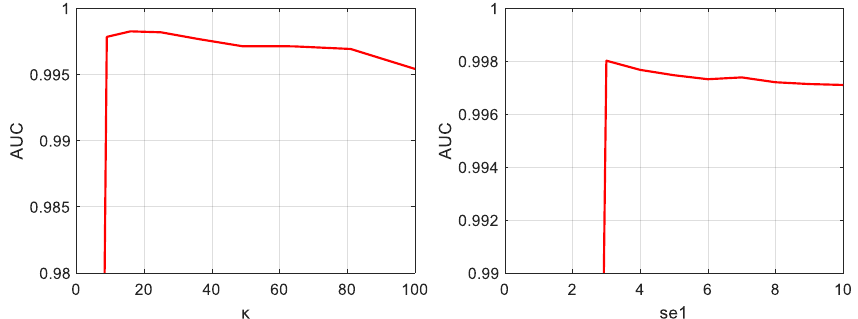
Figure 14. Influence of parameters κ and se 1 over the MPAF performance on the ABU-Urban-3 dataset.